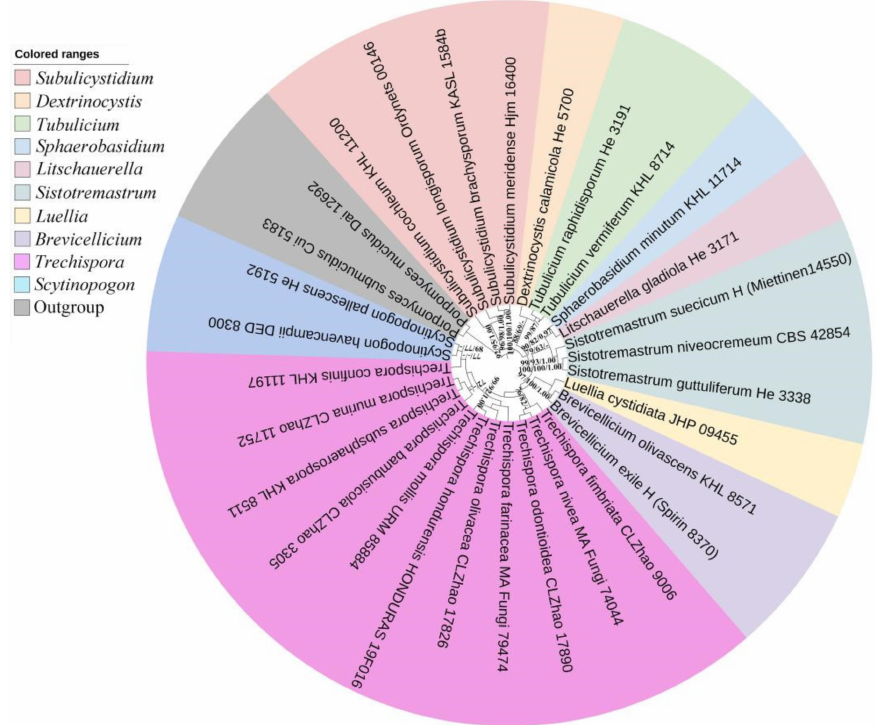
Figure 1. Maximum parsimony strict consensus tree illustrating the phylogeny of Trechispora and related genera in Trechisporales based on 5.8S+nLSU sequences. The genera represented by each color are indi- cated in the upper left of the phylogenetic tree. Branches are labelled with maximum likelihood bootstrap value (cid:61) 70%, parsimony bootstrap value (cid:61) 50%, and Bayesian posterior probabilities (cid:61) 0.95,